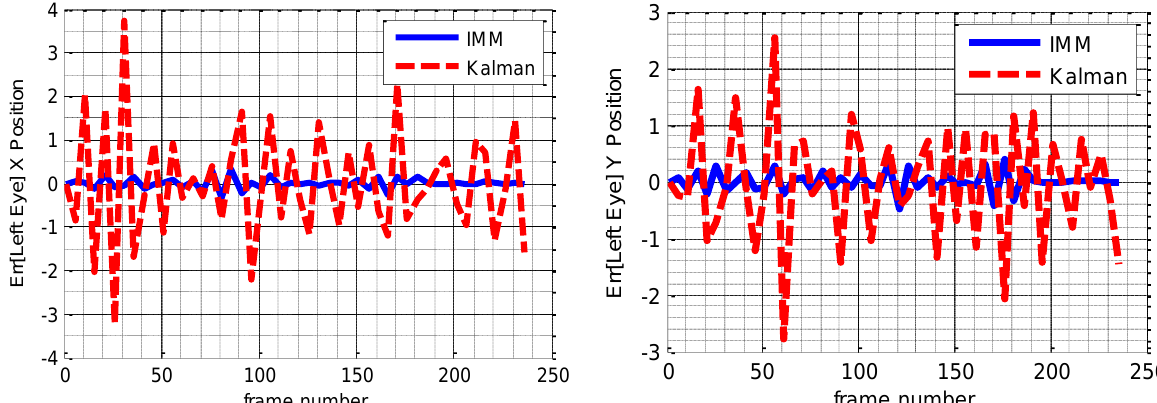
Figure 7. The error of left eye estimation of